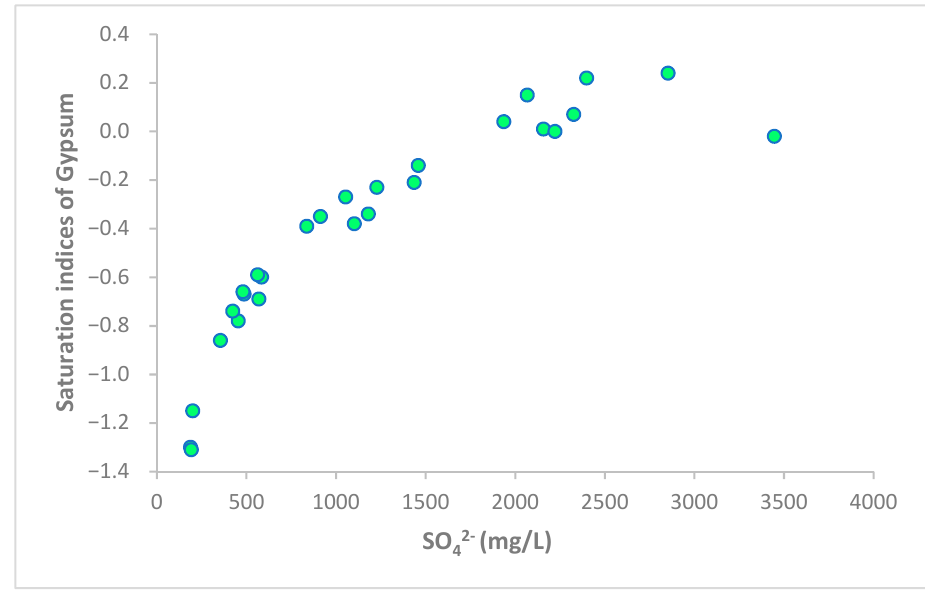
Figure 9. Saturation index of Gypsum Vs SO 4 .